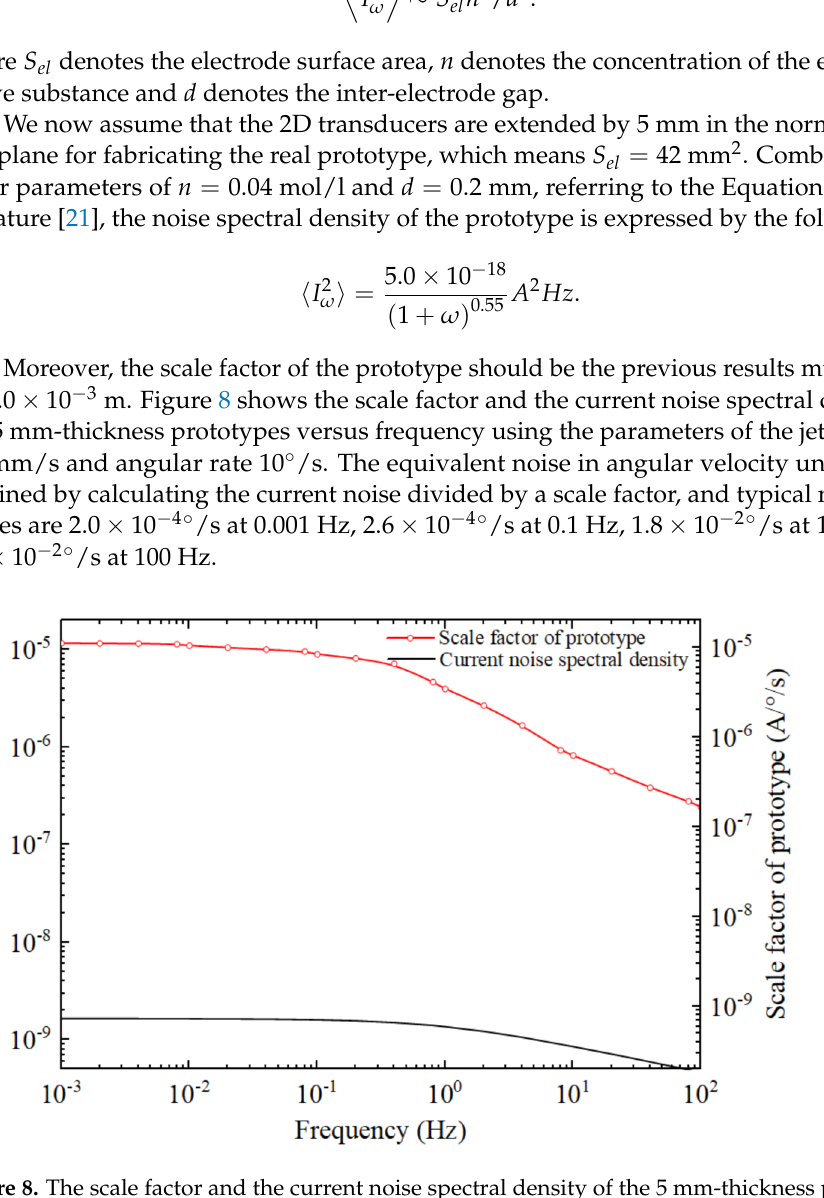
Figure 8. The scale factor and the current noise spectral density of the 5 mm-thickness prototypes versus frequency using the parameters of the jet flow rate 0.3 mm/s and angular rate 10 ◦ /s. Due to the above calculation results being only derived from the effect of Coriolis